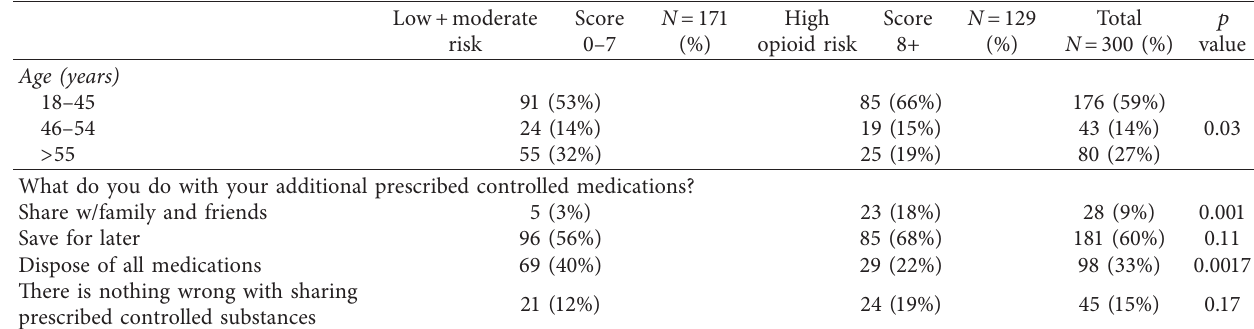
Figure 1: The cumulative number of risk factors (RFs) in the ED population assessed by gender. Table 2: The perception of sharing prescribed controlled substances by opioid risk